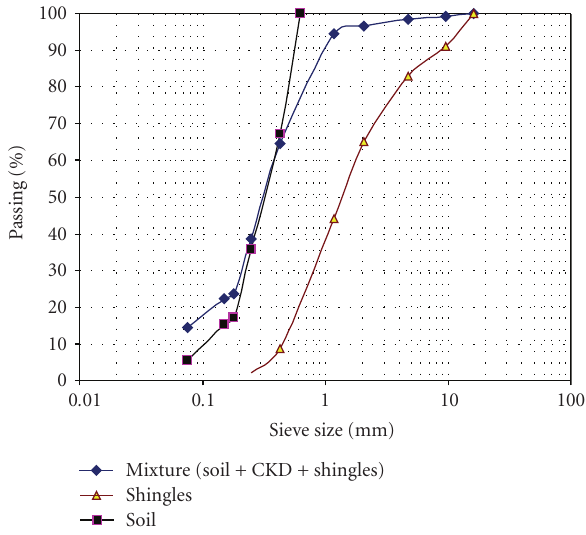
Figure 1: Particle size distributions for tested soil, shingles (RAS) and the combined Soil, RAS, and CKD.